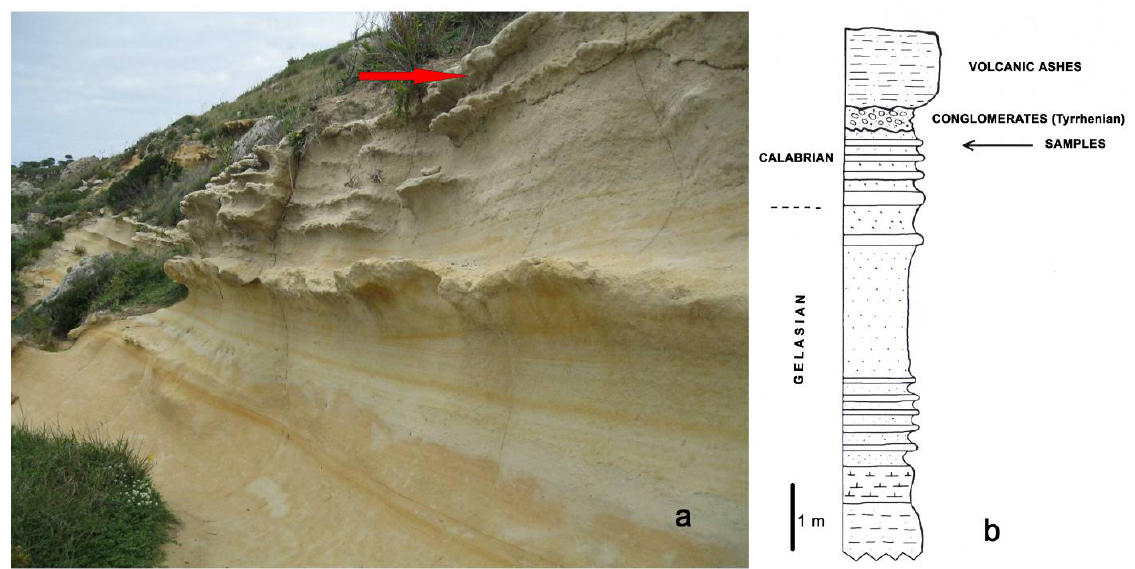
Figure 2. The mid-upper part of the sandy-silty sedimentary succession cropping out at Cala S. Antonino. ( a ) with the “Sicilian” greyish sandy layers marked by the arrow and ( b ) the corresponding